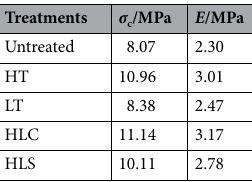
Table 2. Compression strengths and elastic moduli of the HNIW/FOX-7 based PBX columns.